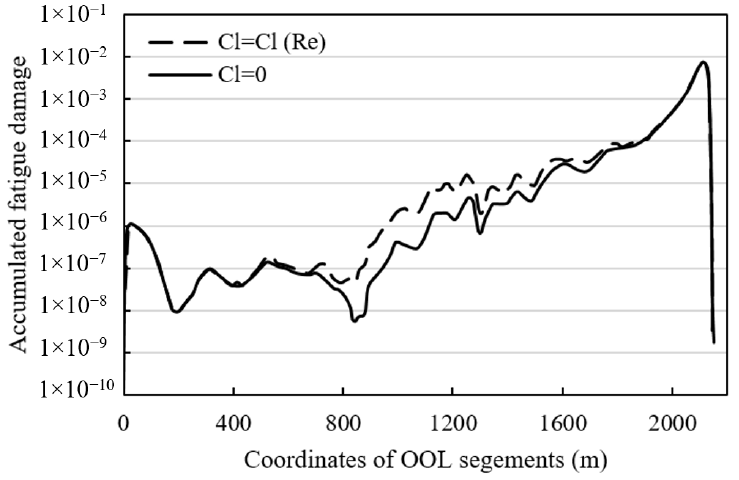
Figure 21. Fatigue damage distribution of OOL under current loads (90°).